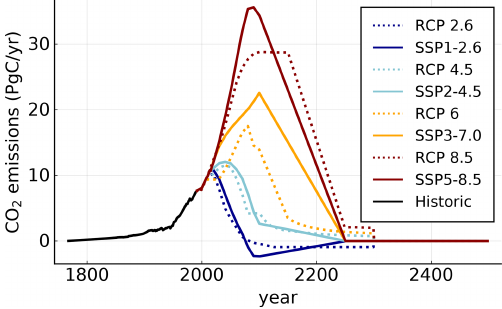
Figure 11. CO 2 emission rate for the RCP and SSP scenarios with their